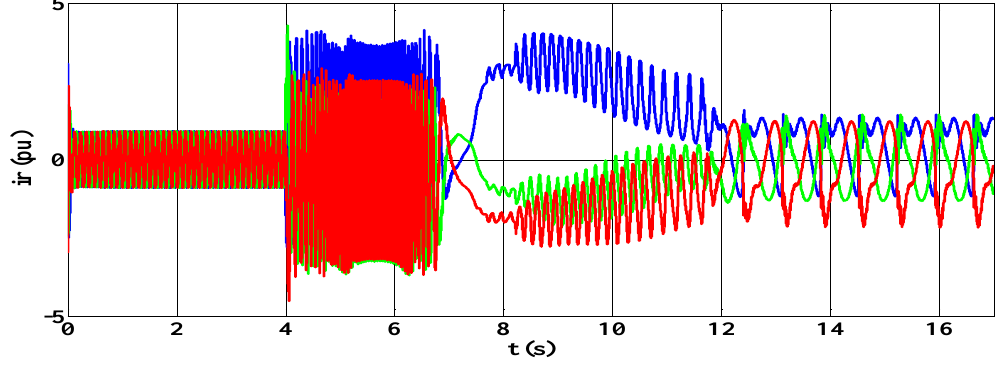
Figure 11. Rotor currents (short-circuit happens at t = 4